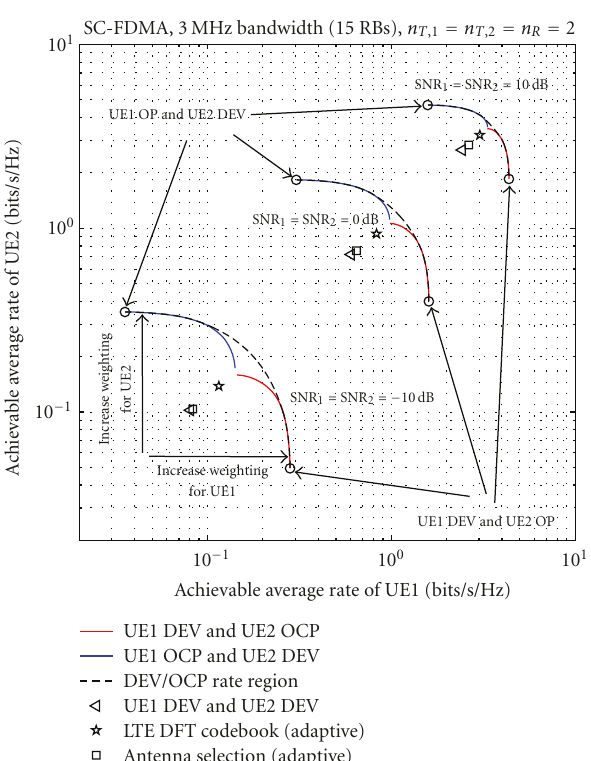
Figure 10: Achievable average rate for two UEs for di ff erent transmit precoding strategies in the SCME “urban macro” scenario according to Table 1. Both UEs share 3MHz bandwidth to com- municate with the serving BS using the same time and frequency resources. Unequal SNR with 10dB di ff erence is assumed for the UEs (SNR UE1 = 0 dB, SNR UE2 =